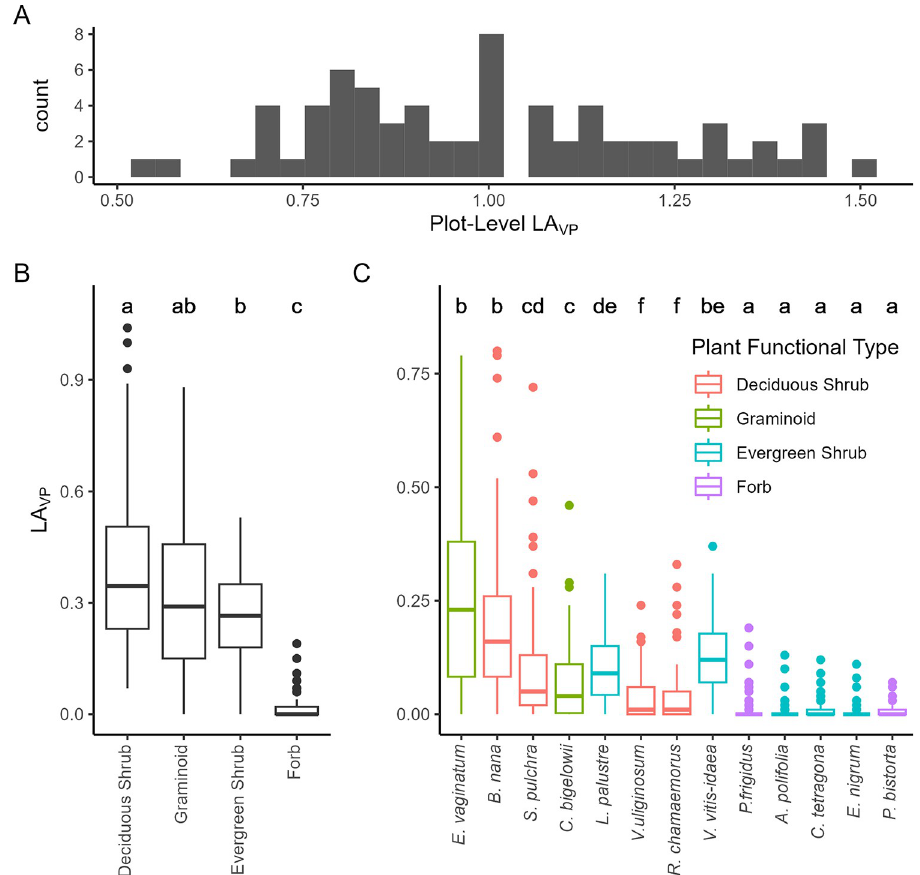
Fig 2. Plot-level LA VP distribution in sample plots (A) and LA VP for each PFT (B), and species (C) in the MAT sample plots. Boxplots in (C) are colored by species’ functional type assignment. Significant differences among PFTs or taxa (Dunn’s Test) in (B) and (C) are indicated by different